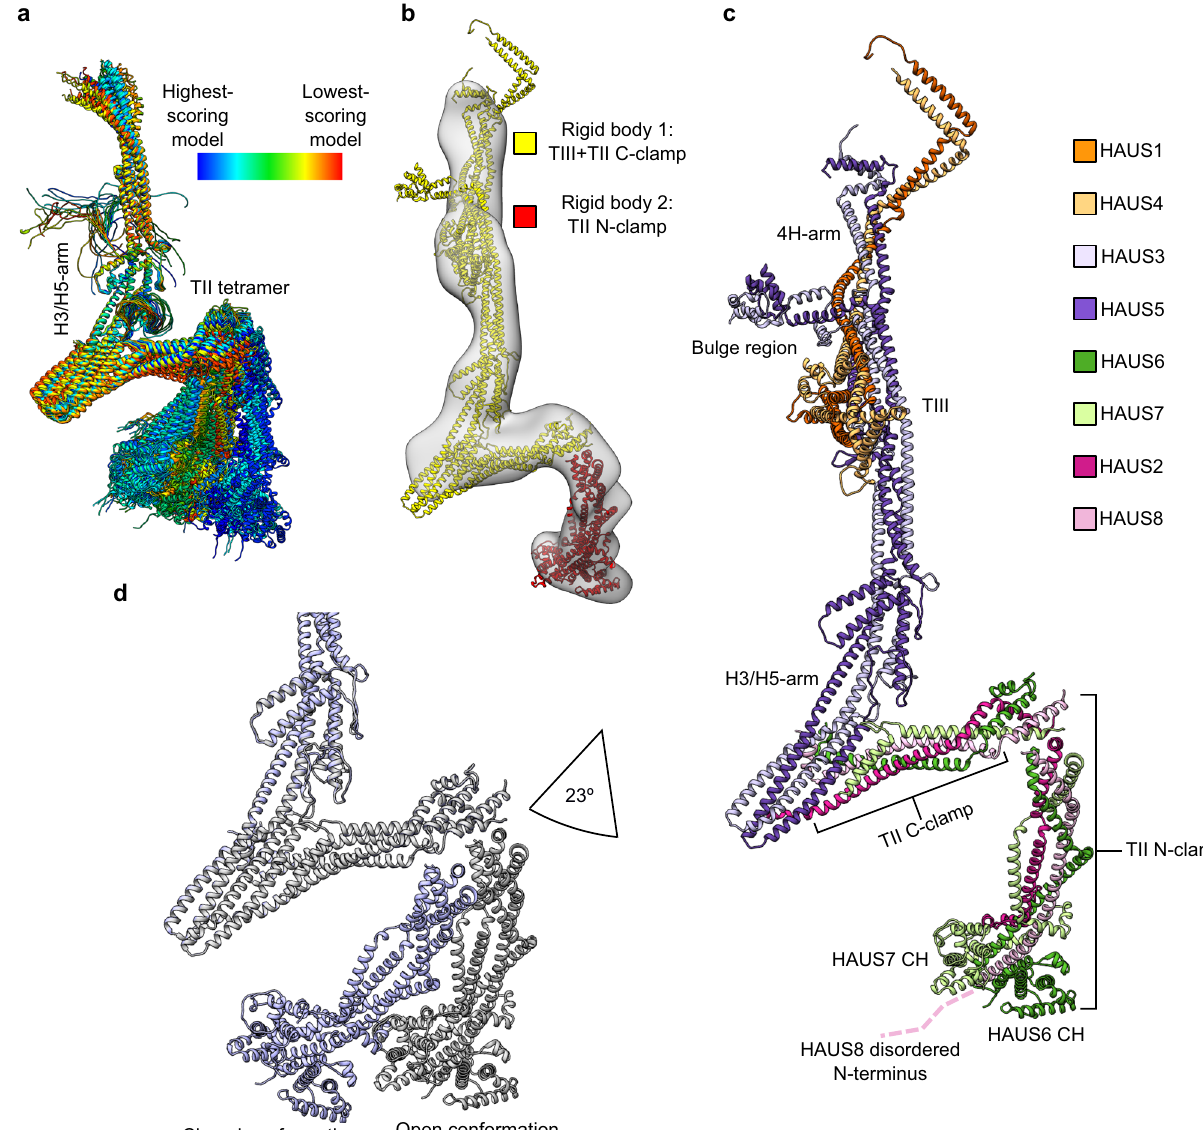
Fig. 5 | Subunit architecture and conformational plasticity of the augmin holocomplex.a Superposition of predicted models forthe augmin TIIIH3/H5arm incomplexwithTII.Theensembleofmodelswascolouredinrainbowschemefrom high (blue) to low (red) prediction score. Colour scheme is given. b Two model segments were fi tted into the negative stain EM 3D reconstruction of the augmin holocomplexasrigidbodies:TIII+TIIC-clamp(yellow);TIIN-clamp(red). c Subunit